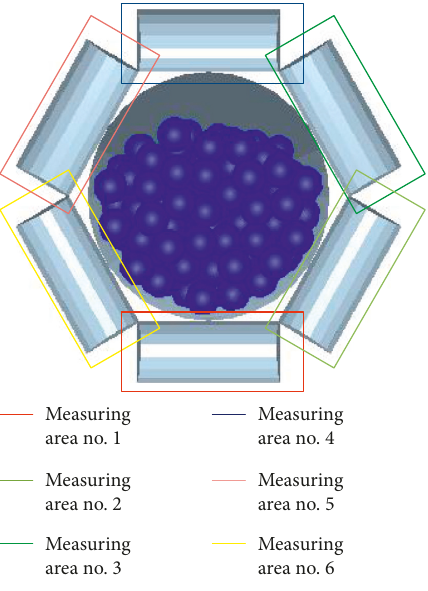
Figure 4: Simulation process. Figure 5: Test device.1, pressure transducer; 2, linear feed guide; 3, conveyor belt; 4, bracket; 5, signal transmission Table 1: Pressure value of the roller group at 60% filling rate.